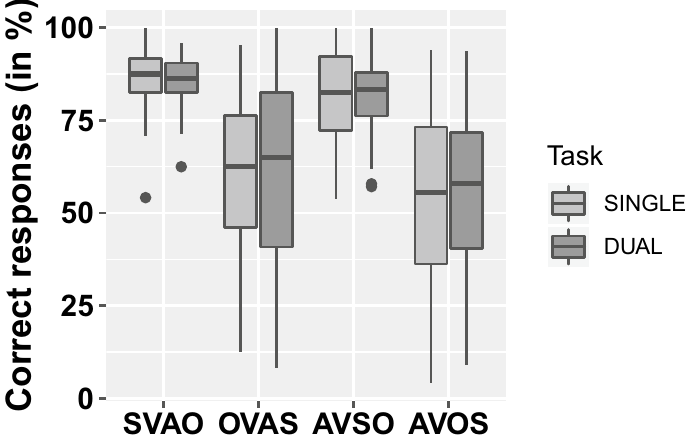
Figure 2. Performance on the picture selection task. Boxplot showing the median and first and third quartile of the percentage of correct responses on the picture selection task as a function of sentence type and load. Statistically significant differences in correct responses were found between all sentence conditions, with performance being highest on canonical SVAO sentences and lowest on AVOS sentences. No significant effect of task condition (single or dual) was found. No significant correlations between performance and PTA-high (hearing loss) or hearing aid experience were found. This figure was created in R (version 3.6.2, www.r-proje ct.org 41 ).